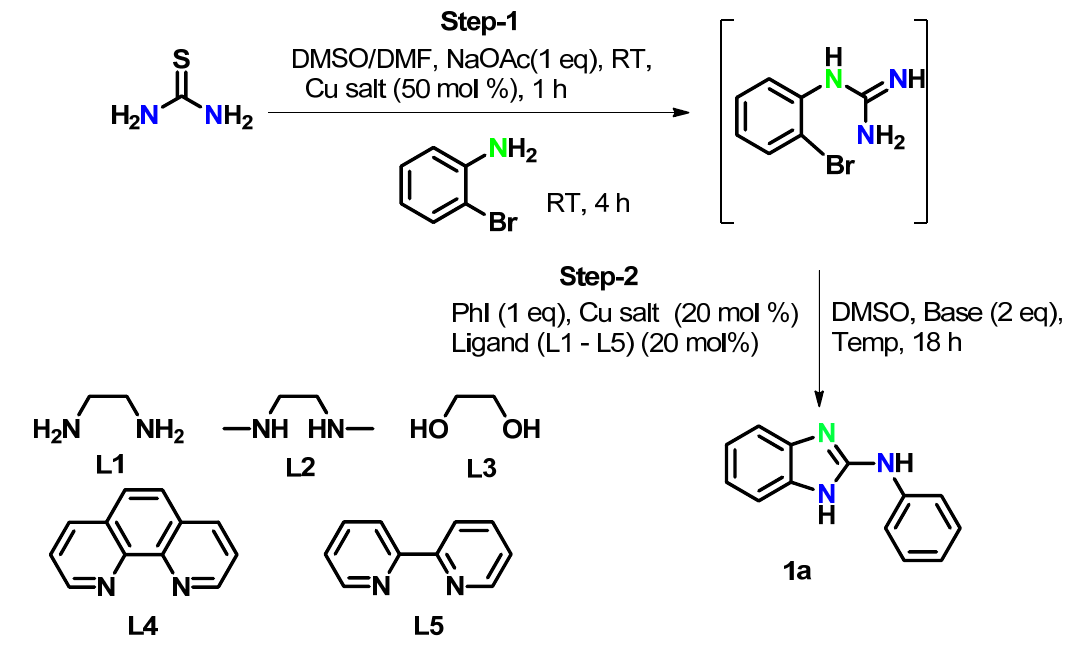
Table 1. Optimization of the reaction for the synthesis of 2-aminophenyl benzoimidazole a